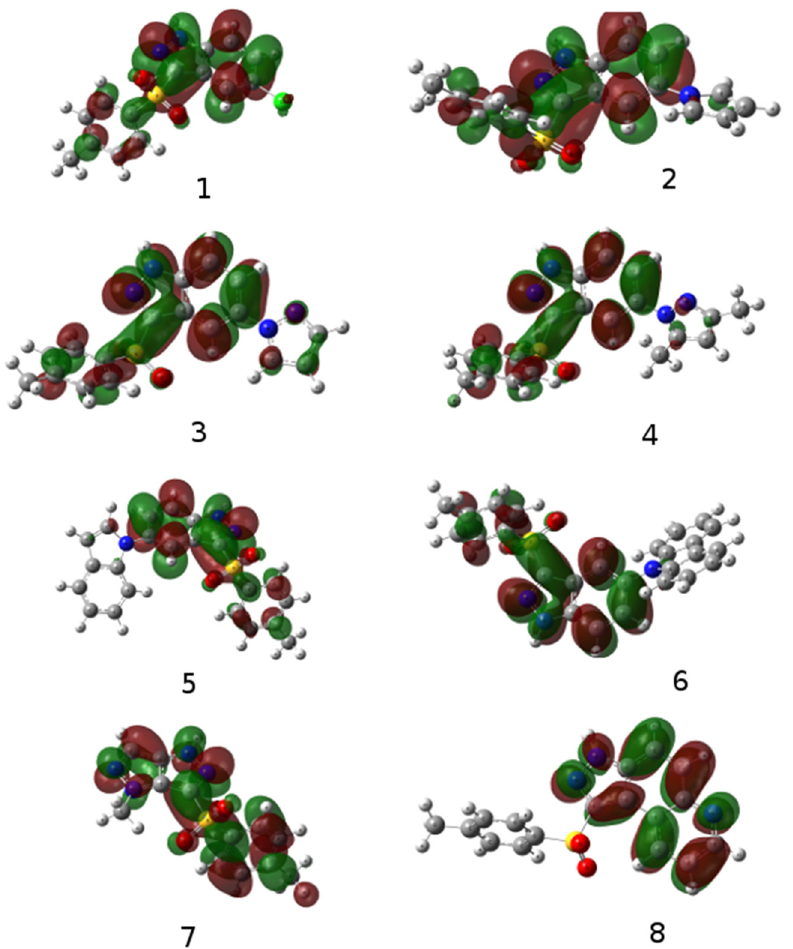
Figure 4: The LUMOs generated for compounds 1 – 8 optimised at the B3LYP/6 - 31G ( d,p ) level of theory in the gaseous phase; vertical excited states were calculated at the B3LYP/6 - 311 ++ G ( 2d,3p ) level of theory in vacuo